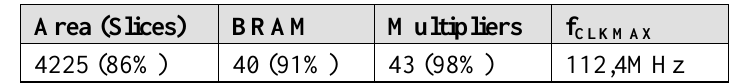
Table 2. Summary of all the resources consumed by the entire developed system on a XC2VP7.